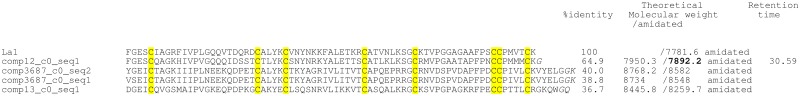
La-1-like peptides found in the U. yaschenkoi transcriptome.The alignment compares the La-1-like peptides encoded by U. yaschenkoi transcripts with the model La1 peptide from Liocheles australasiae. La1 is amidated with a molecular weight of 7781.6 Da. Only the theoretical molecular weight amidated of comp12_c0_seq1 (in bold) was detected in the proteome of U. yaschenkoi [41], in retention time 30.59. La1 peptide has eight cysteines that are conserved in all the putative La-1-like peptides found herein (highlighted in yellow). The percentage of identity with respect to La1 is shown. Note: comp12_c0_seq1 and comp15_c0_seq1 (not shown) encode the same peptide; comp3687_c0_seq2 and comp4167_c0_seq2 (not shown) encode the same peptide; comp3687_c0_seq1 and comp4167_c0_seq1 (not shown) code for the same peptide and comp13_c0_seq1 and comp16_c0_seq1 (not shown) code for the same peptide.